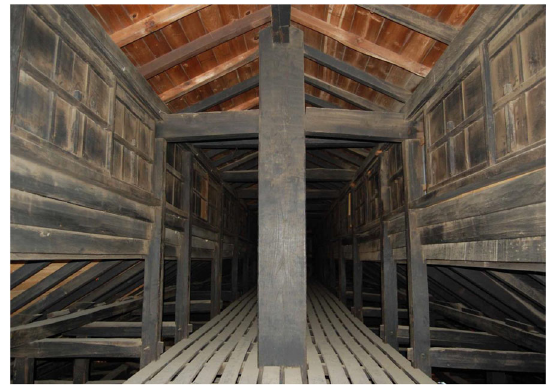
Fig. 1 Interior of the s ō -yagura of the Tajima Yahei Sericulture Farm. (Source: Satoshi